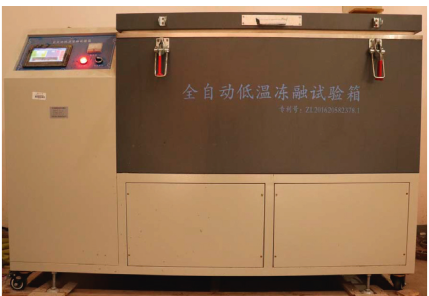
Figure 3: TDS-300 type automatic low-temperature freezing- thawing container.